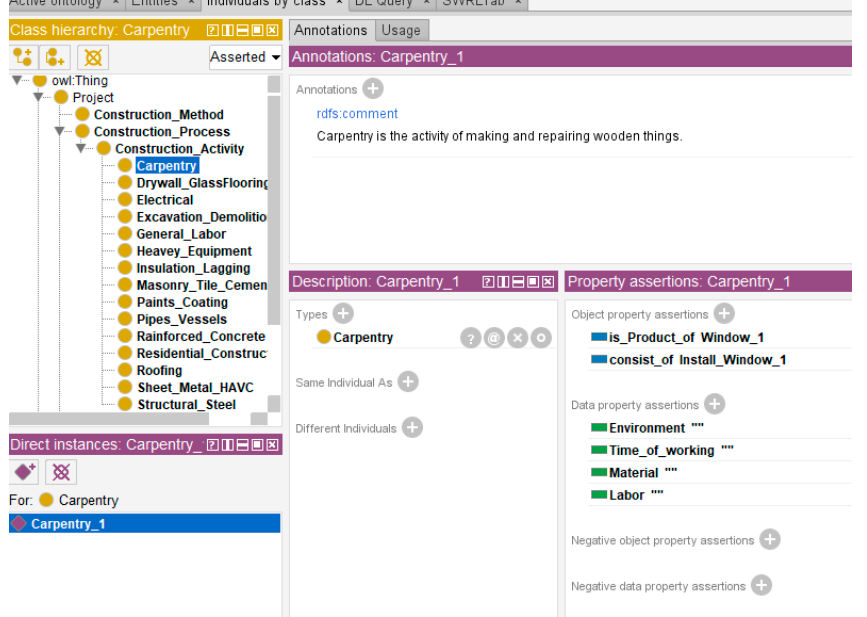
Figure 9. Instances in HSM-Onto.